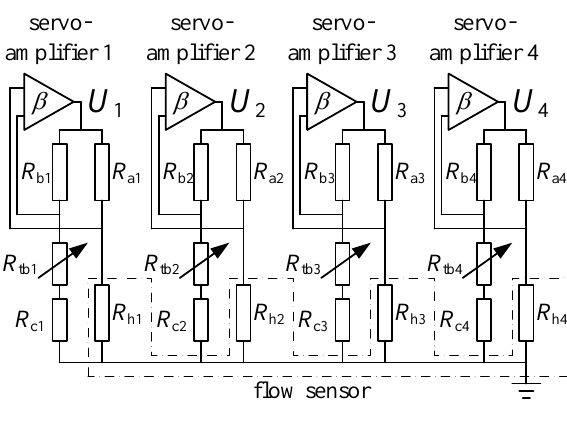
Figure 6. Scheme of the conditioning